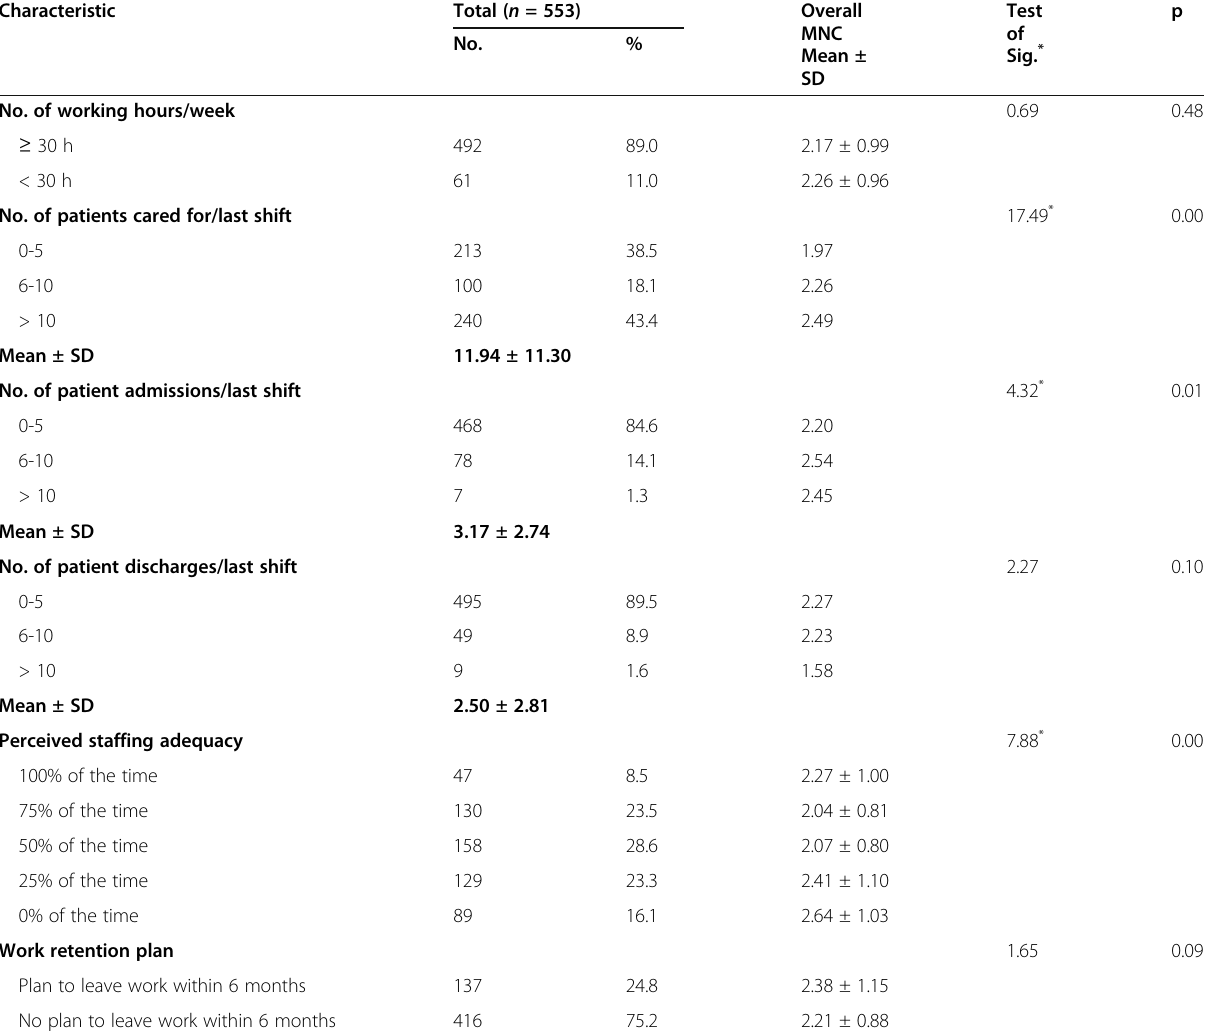
Table 3 Association between overall missed nursing care and staffing adequacy, workload, and intention to leave Characteristic